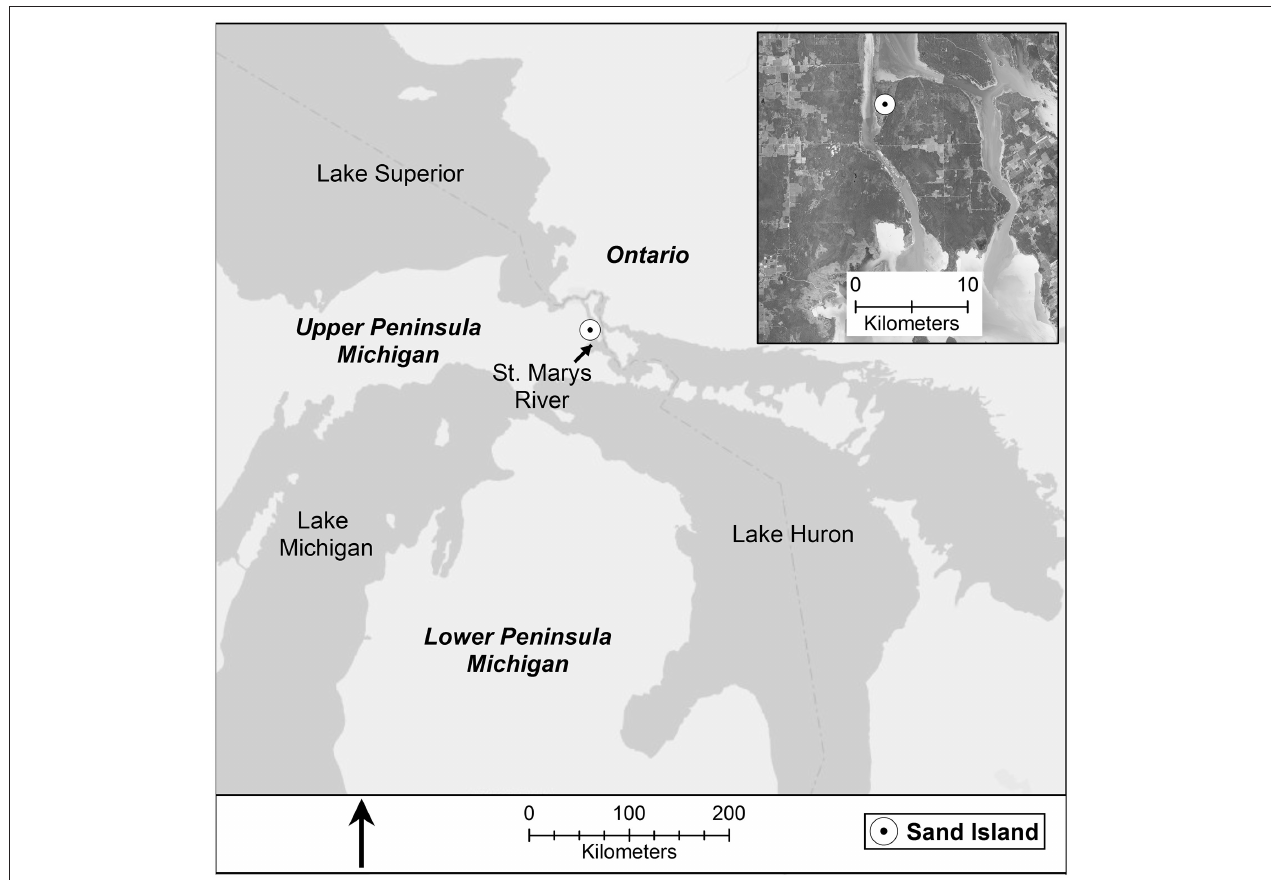
FIGURE 1 | Study region, the St. Marys River, the connecting channel between Lake Superior to the north and Lake Huron to the south.